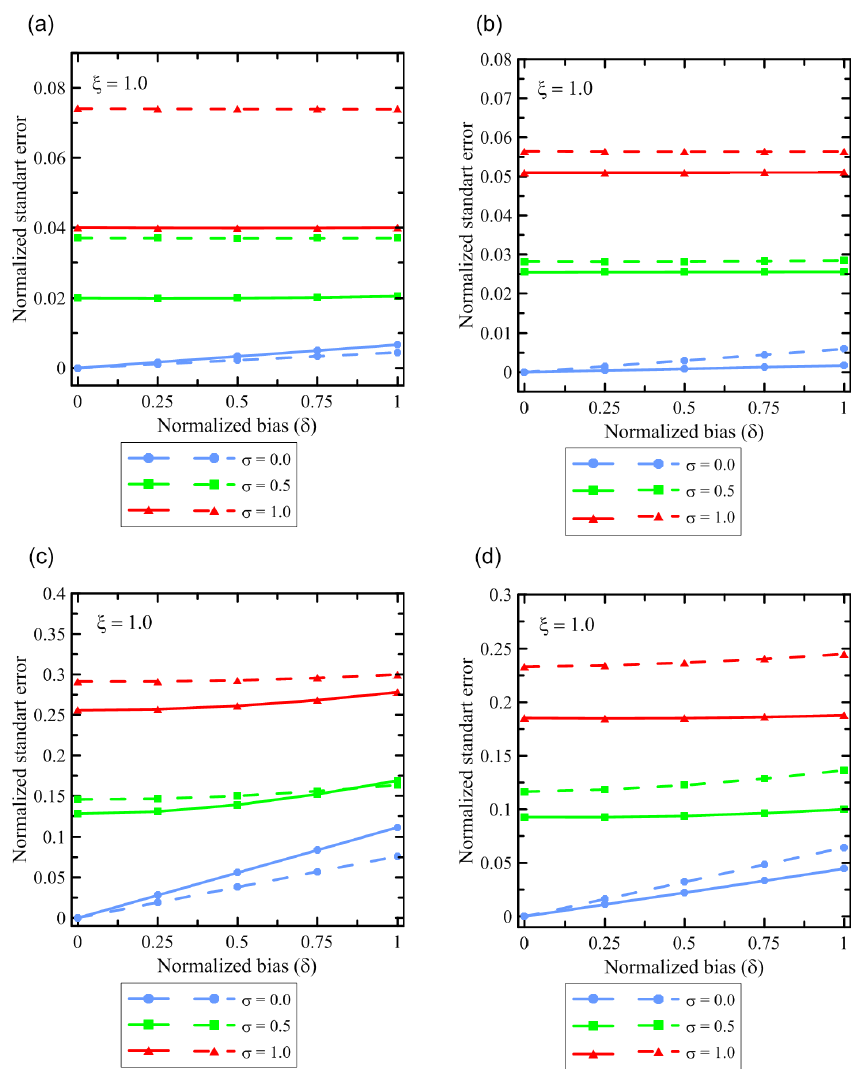
Figure 7. The same as in Fig. 6 but for the dependencies of the normalized standard error on the scaling factor, δ , characterizing the bias applied to the synthetic data (see Sect. 3.5 for further